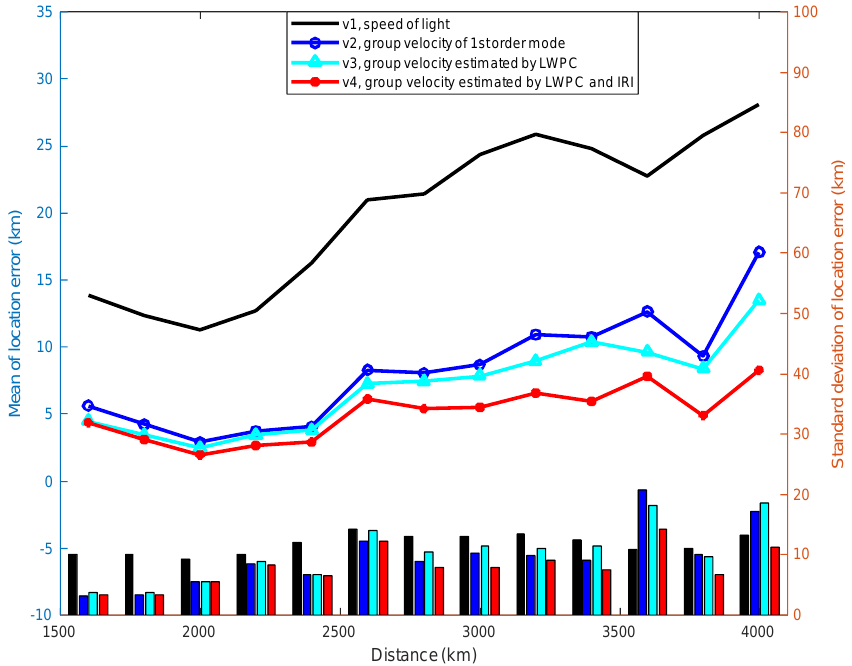
Figure 8. The relationship of lighting location errors with the distance from lightning events to ELLN The comparison is made among different methods of group velocity estimation using lightning location results at nighttime. The curves are the mean values, and the bar graphs are the standard deviations, which correspond to the left and right y-axes respectively.